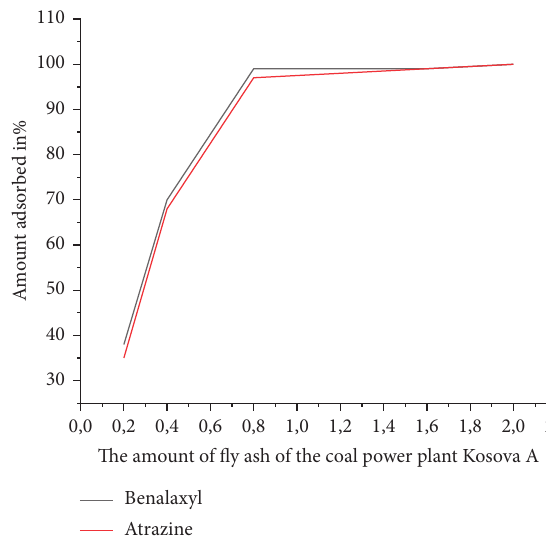
Figure 6: Amount of adsorbed % of benalaxyl and atrazine in coal FAPP (Kosovo A) depending on the amount of coal FAPP (Kosovo A).